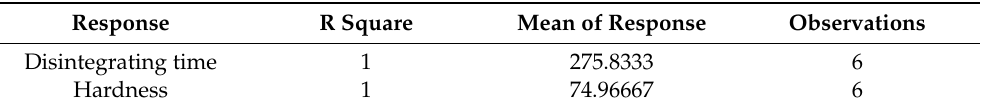
Table 8. Summary of fit of the standard least squares regression model used to fit two responses separately in DoE analysis. Response R Square Mean of Response Observations Disintegrating time 1 275.8333 6 Hardness 1 74.96667